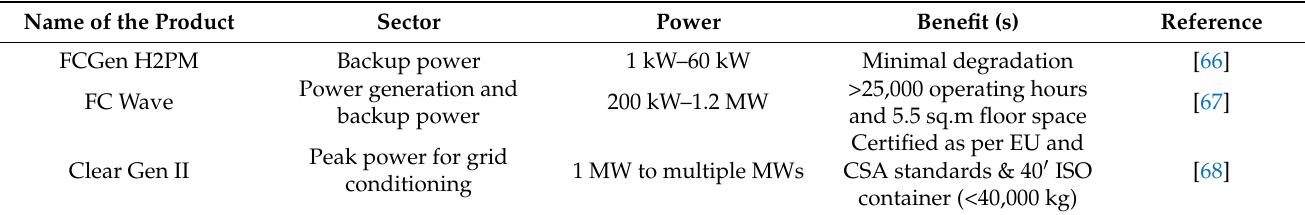
Table 8. Commercial stationary fuel cell power modules of Ballard Inc.